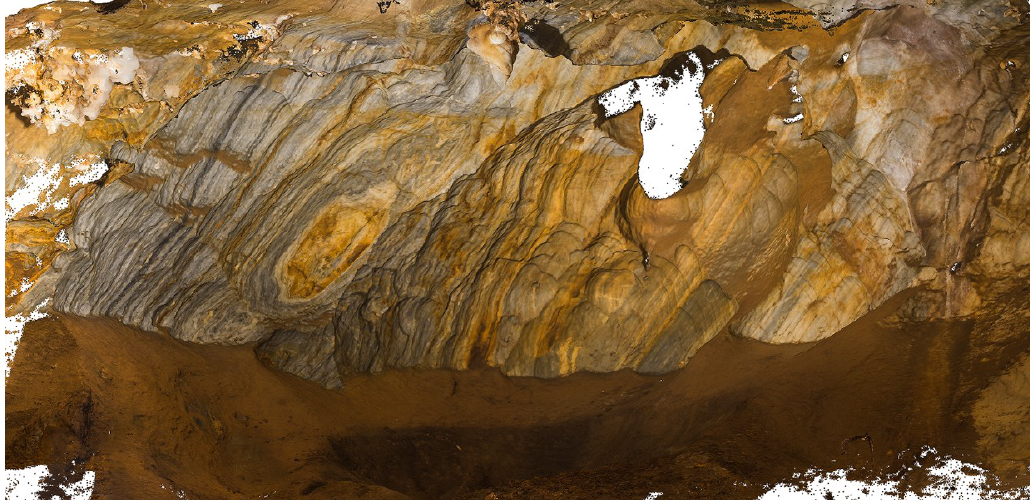
Table 1. Parameters of imaging and image processing in APSC, Version 1.2 software.